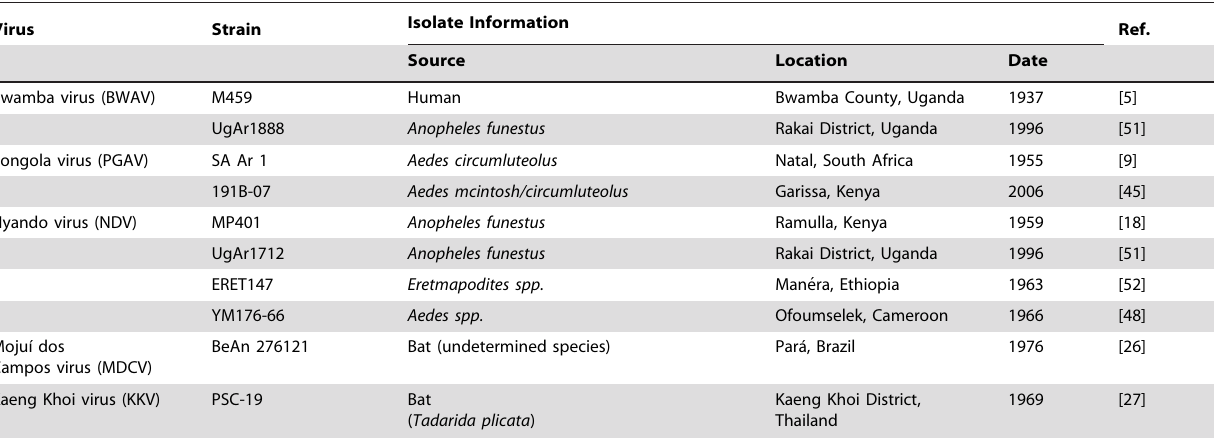
Table 1. Virus strains used in this